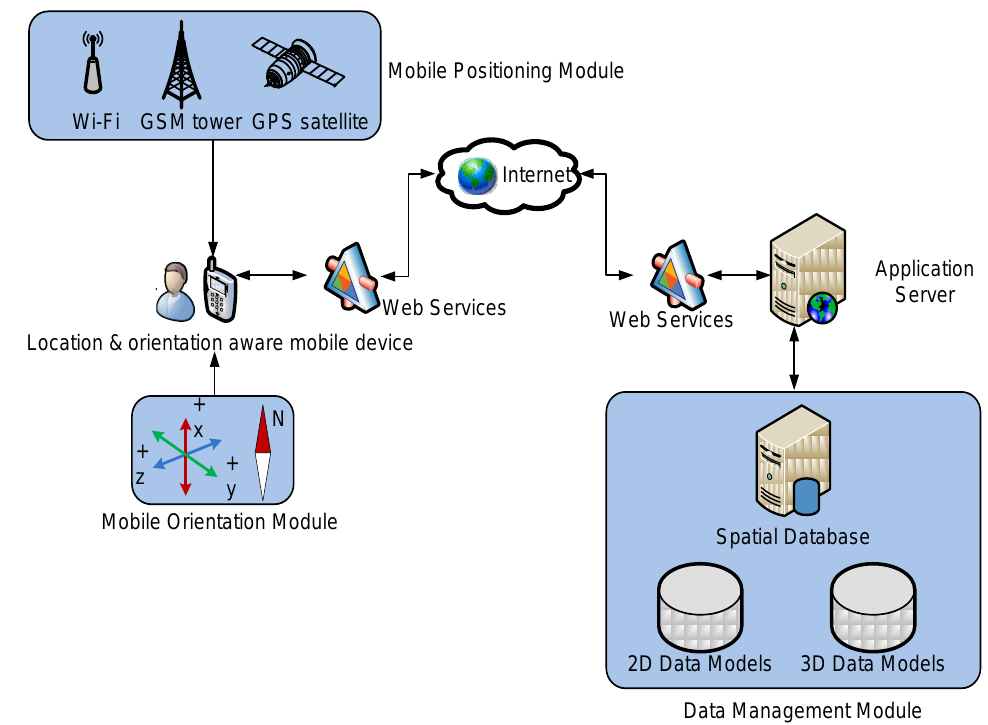
Figure 3. Component diagram for the overall 3DQ system